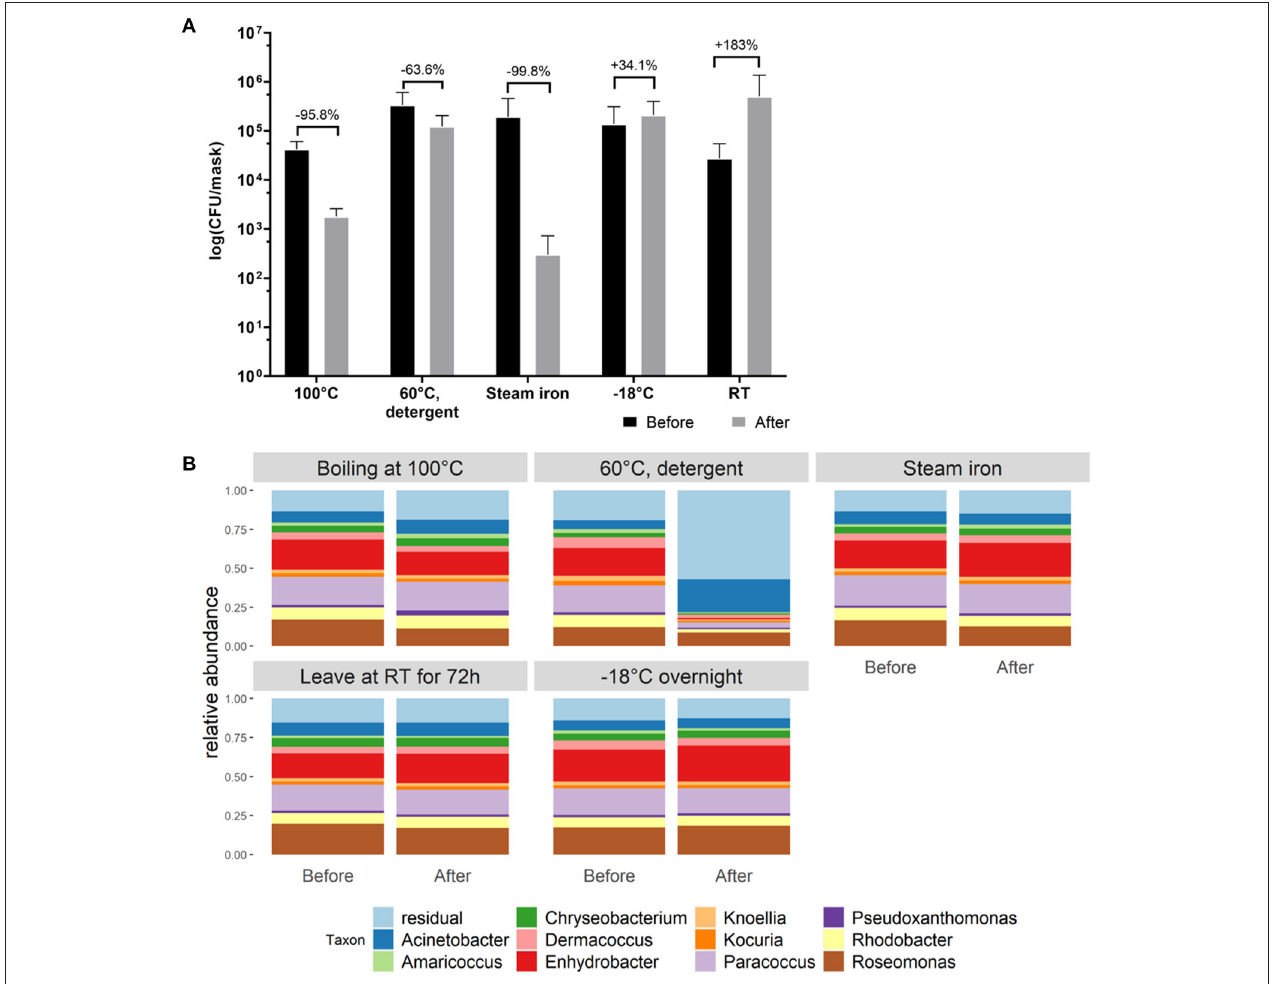
FIGURE 3 | Evaluation of different cleaning methods to reduce bacterial load on cotton face masks. (A) Cotton mask bacterial load before and after mask cleaning. Data shown as the average CFU/mask (calculated to represent the whole face mask) after cultivation on BHI agar (cultivation on LB agar in Supplementary Figure 2 ). Statistics were performed using two-way ANOVA with Sidak’s multiple comparisons test. No significant differences were detected. (B) Taxonomic bacterial community composition on the face masks at genus level for the different cleaning methods, before and after cleaning, analyzed via 16S rRNA gene amplicon sequencing.